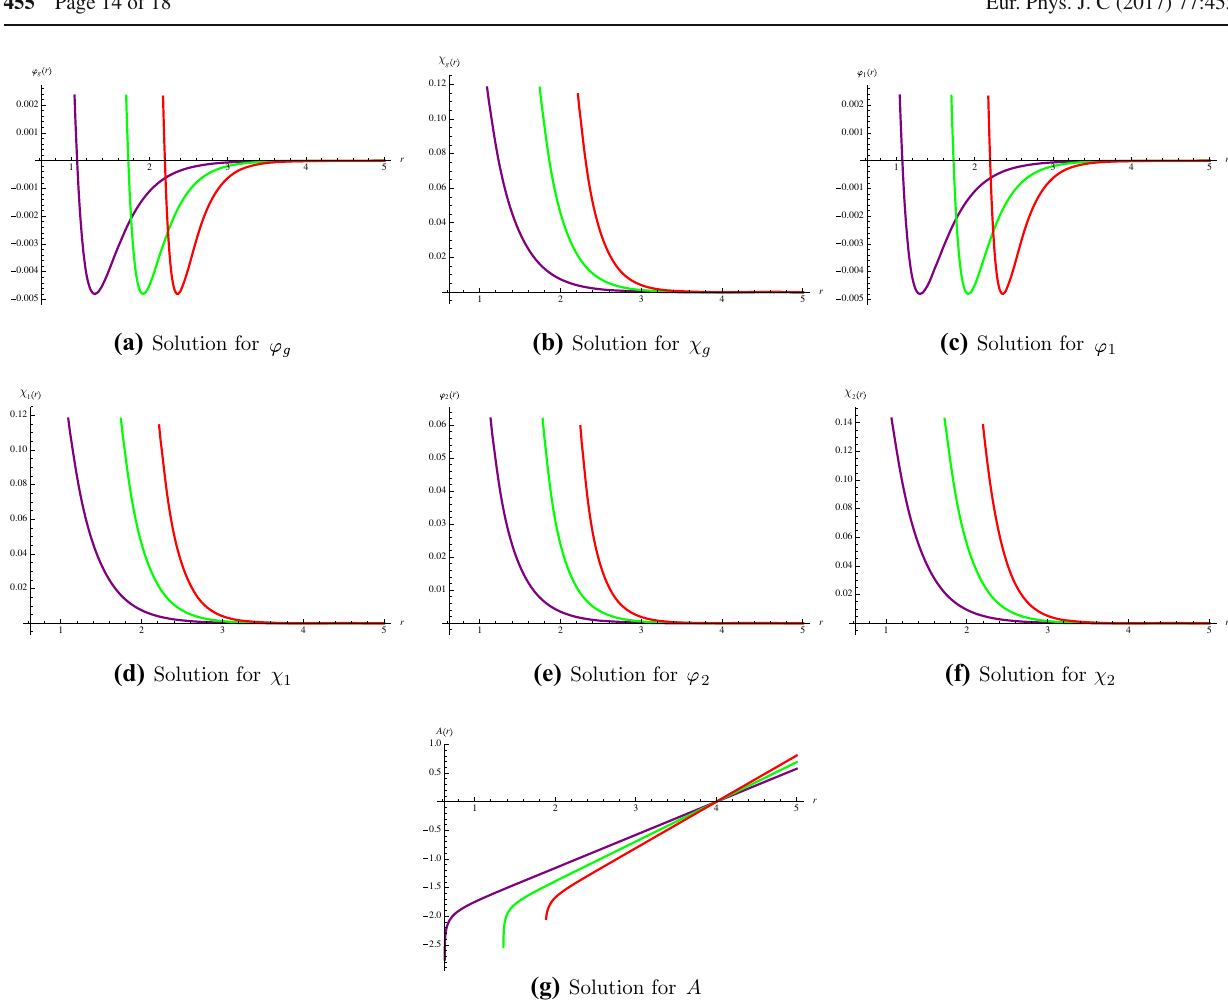
Fig. 5 N = 1 RG flow solutions from type IIA compactification with λ = 1 ( purple ), λ = 1 . 2 ( green ) and λ = 1 . 4 ( red